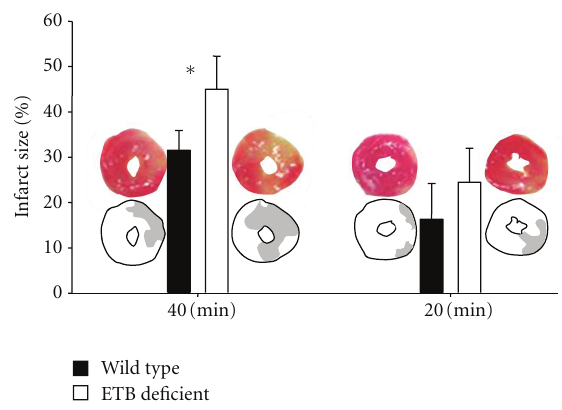
Figure 3: Infarct size (expressed as percent ratio of necrotic area/area at risk) in wild-type (dark bars) and ETB-deficient rats (white bars) after 40- and 20-minute regional ischaemia. Asterisk denotes significant di ff erences between the two groups. Representative examples of infarct size measurements (histological samples and schematic illustrations) are shown adjacent to the